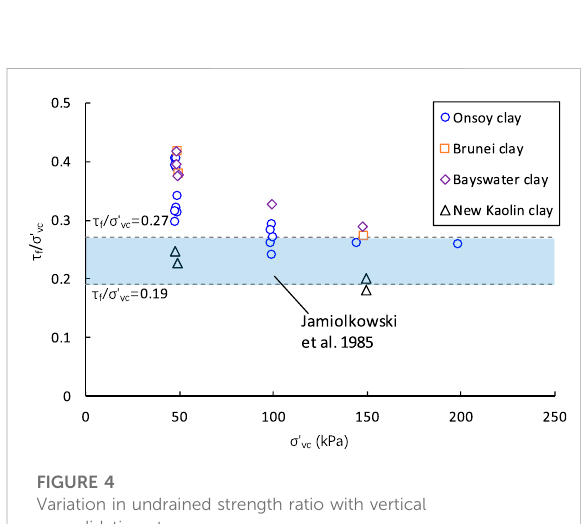
FIGURE 6 Variation in undrained strength ratio with shearing rate.